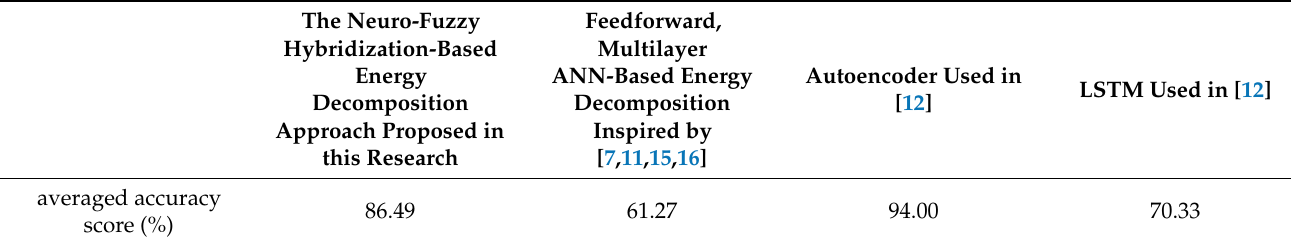
Table 5. Comparison among the proposed energy decomposition approach, an ANN-based energy decomposition method, the Autoencoder, and the LSTM for energy